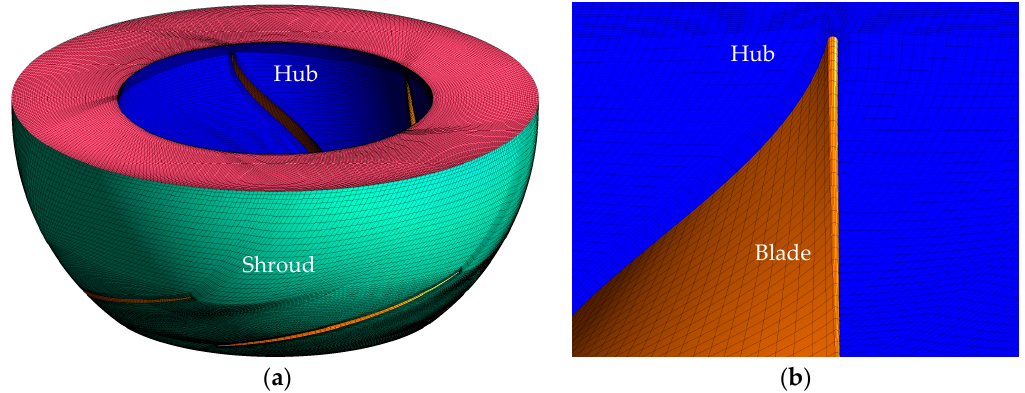
Figure 2. Mesh of the impeller domain and topology. ( a ) Impeller domain; ( b ) O topology and encryption of blade.